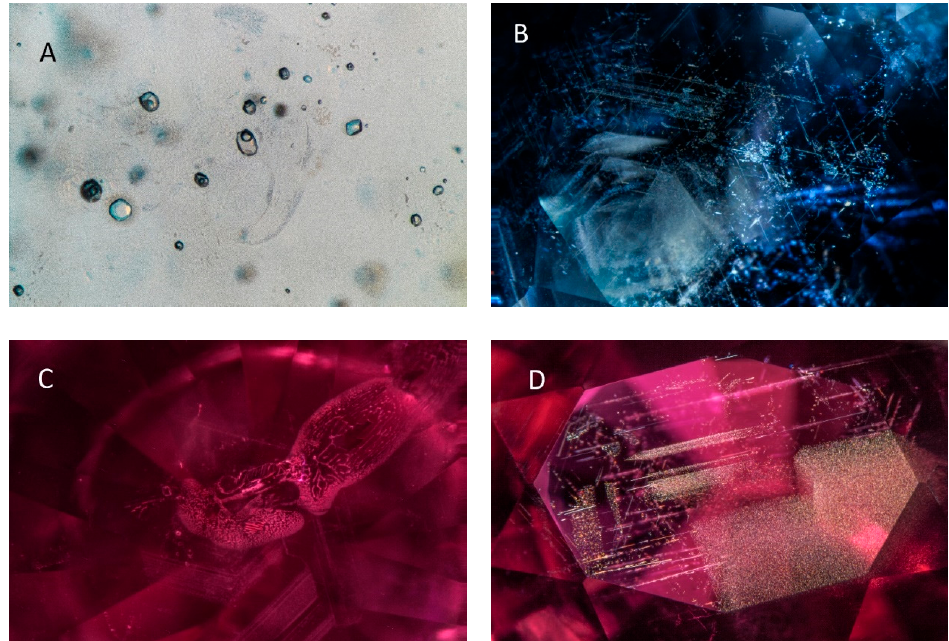
Figure 6. Photomicrographs of typical inclusions in secondary Montana ( A , B ) blue sapphires representing (A) melt inclusions and (B) hexangonally arranged rutile silk and ( C , D ) pink sapphires and rubies representing ( C ) melt inclusions and ( D ) hexagonally arranged bands of rutile silk. Photomicrographs by ( A – C ) Aaron C. Palke and ( D ) Tyler Smith. Fields of view: ( A ) 1.64 mm, ( B ) 4.08 mm, ( C ) 2.23 mm, and ( D ) 3.57 mm.